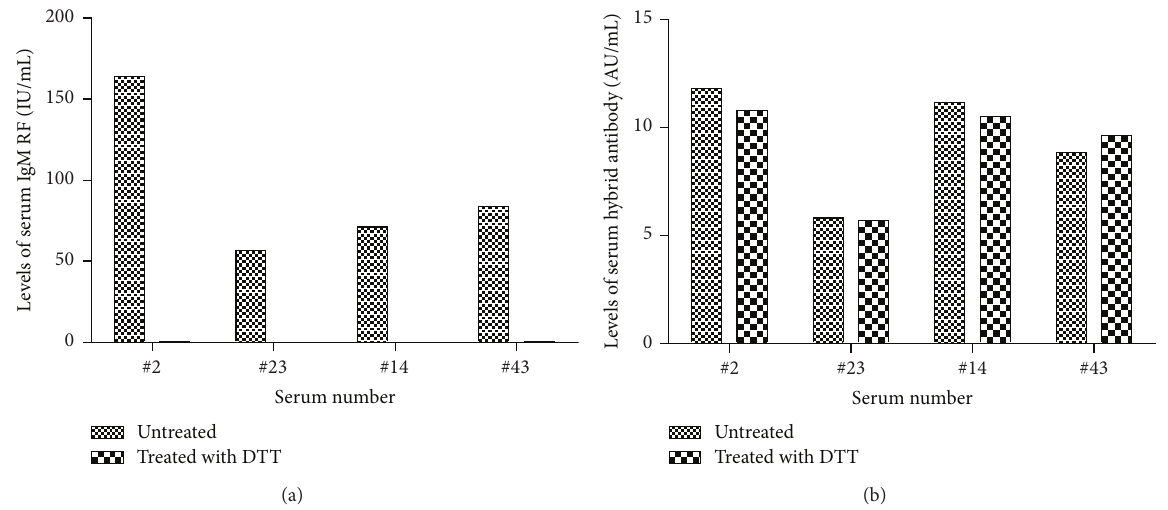
Figure 2: Serum IgM RF and 𝜅 / 𝜆 hybrid antibodies levels after treatment with DTT. (a) The effect of treatment with DTT on removing IgM RF. Four RF positive RA serum samples were incubated with DTT for 60 min; all or most of the IgM RF were eliminated. The concentrations of IgM RF (IU/mL) were measured by ELISA. (b) Levels of 𝜅 / 𝜆 hybrid antibodies of RA serum before and after being eliminated with IgM RF. Removing IgM RF completely showed little influence on the levels of serum 𝜅 / 𝜆 hybrid antibodies. Concentrations of 𝜅 / 𝜆 hybrid antibody are presented in arbitrary units